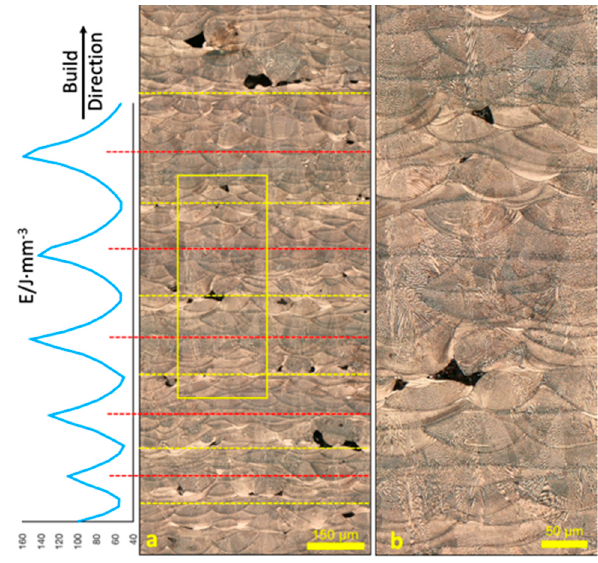
Figure 2. ( a ) Optical micrograph of the x-z plane corresponding to the variation of laser energy input and ( b ) detailed optical micrograph of the region in the yellow rectangle.